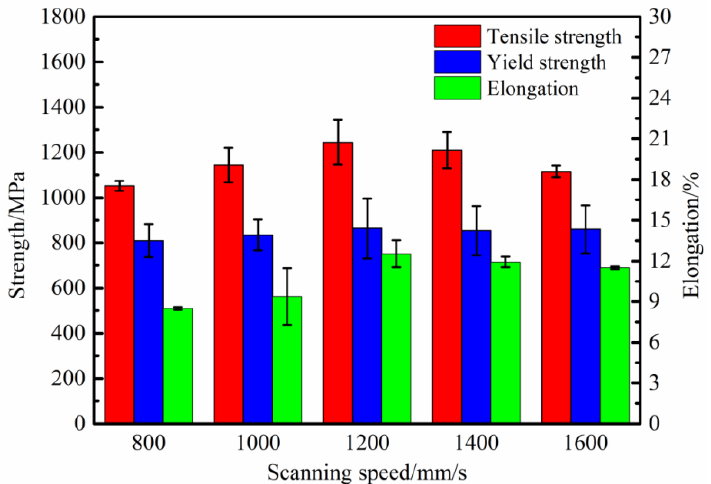
Figure 10. Influence of different scanning speeds on the tensile properties of K418.